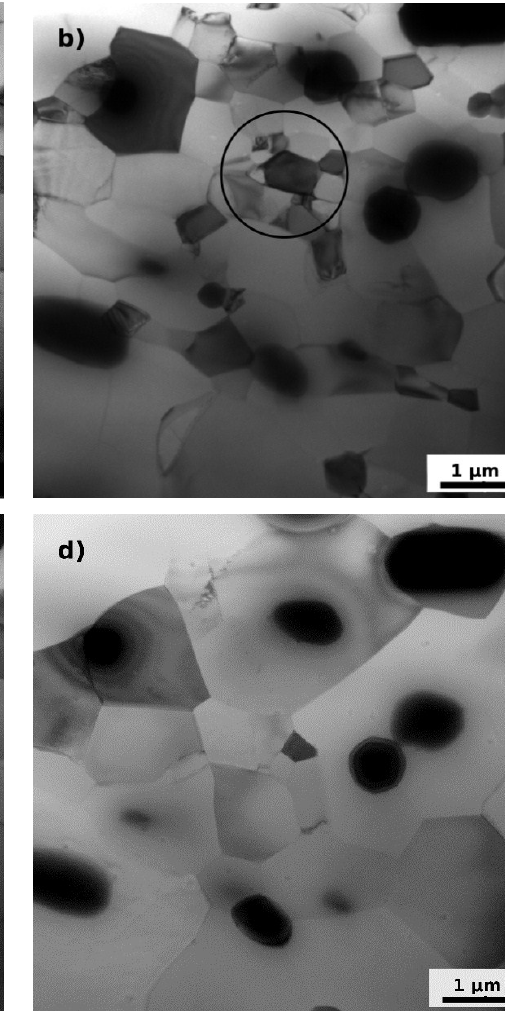
Figure 9. TEM micrographs of F3 material after ARB processing and annealing up